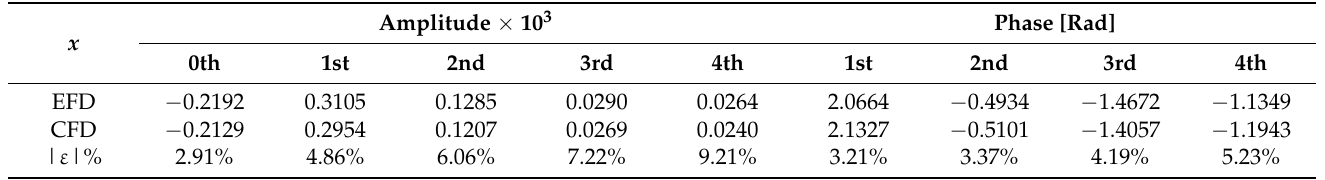
errors. Table 19. Harmonic amplitudes and phases of the total resistance coefficient (𝐶 (cid:3021) ) for the 𝐹𝑅𝑥𝑧𝜑𝜃 quartering waves scenario. 𝑪 𝑻